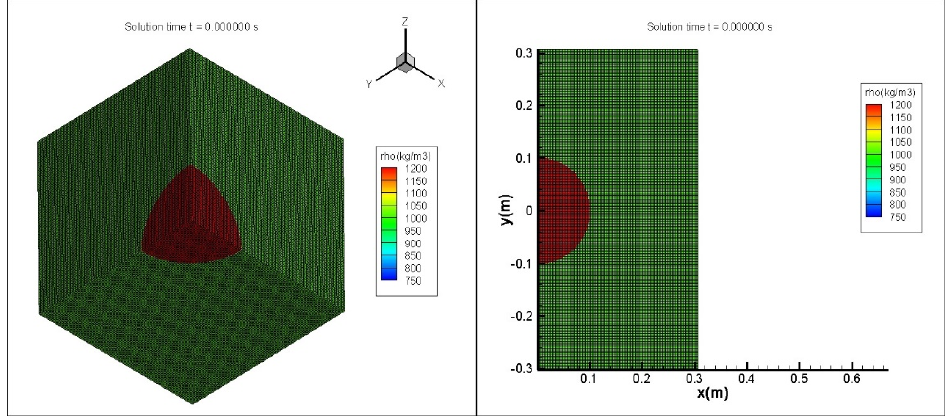
Figure 17. Discretization of 3D and 2D axi-symmetric domains and the gaseous bubble. Contours including the primitive variables at 4.55 × 10 − 5 s using the 3D third-order solver are plotted in Figure 18. In total, 1/8 of the domain is plotted, but the full domain is used for the computation. Contours using the 2D axi-symmetric third-order solver are plotted in Figure 19. The comparisons between the 3D, 2D axi-symmetric and 1D spherical velocity in the x direction, and pressure along the 1D domain of x ∈ [ − 1.0, 1.0 ] ft, y = 0.0 ft and z = 0.0 ft, and are shown in Figure